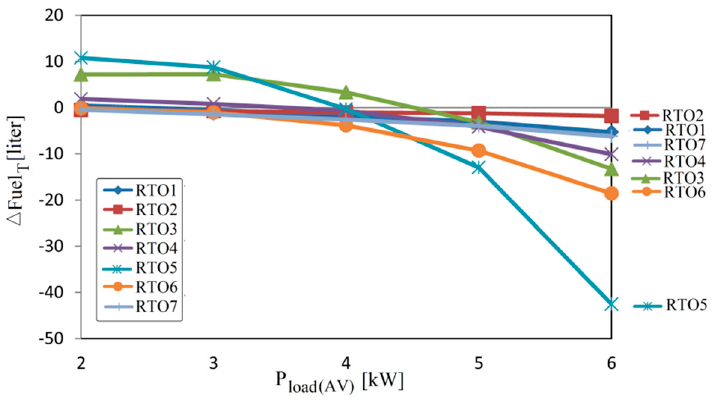
Figure 6. Fuel saving for k fuel = 25 and di ff erent P load(AV) .